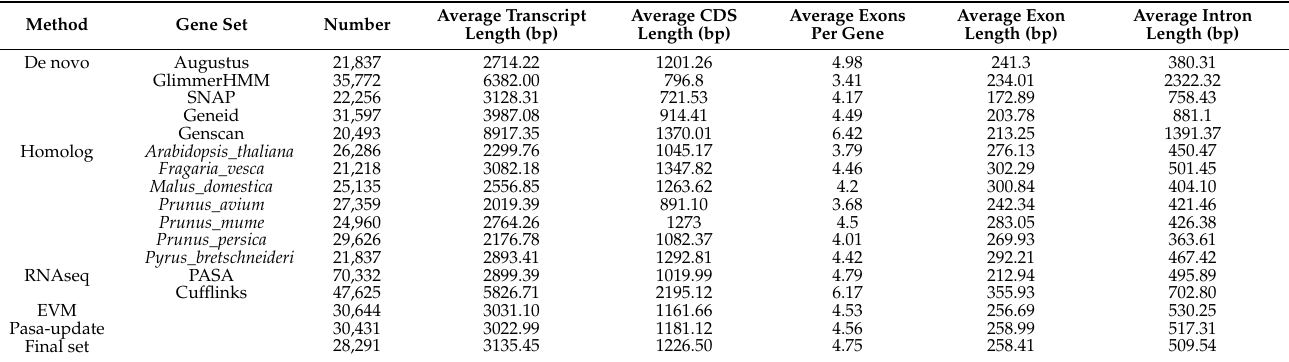
Table 3. Summary of protein-coding genes annotation in P. campanulata via three